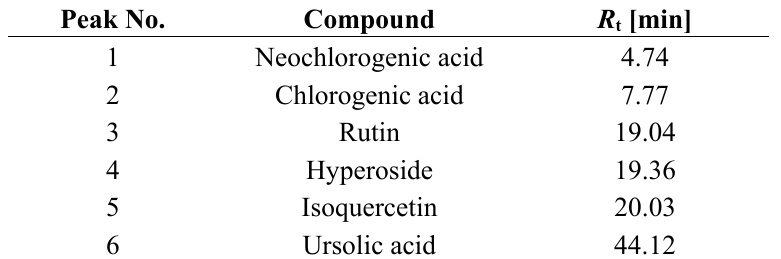
) in the HPLC fingerprint. t